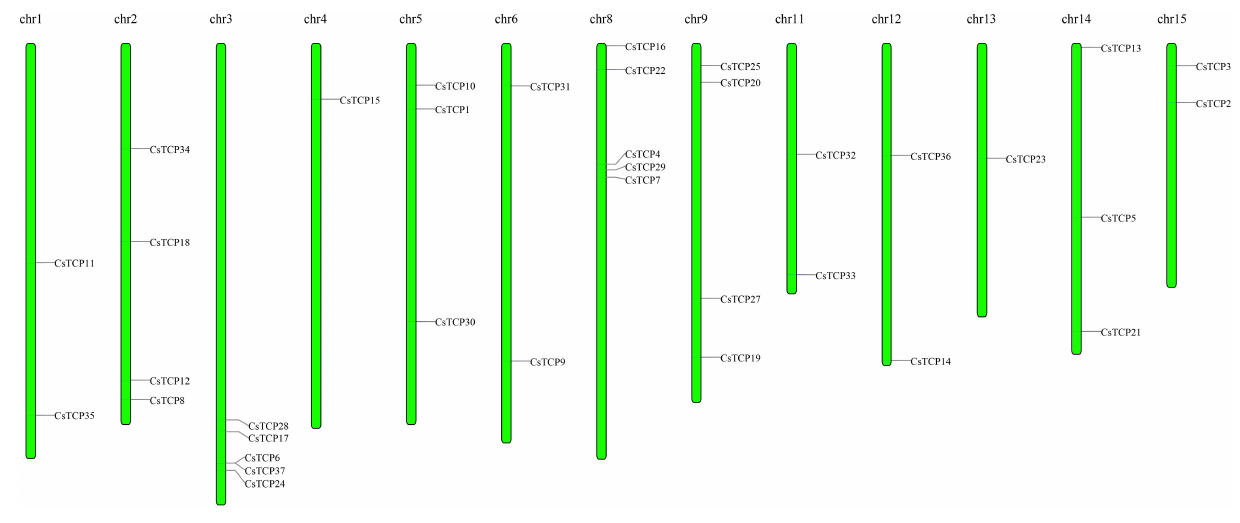
FIGURE 1 | The chromosomal location of CsTCP